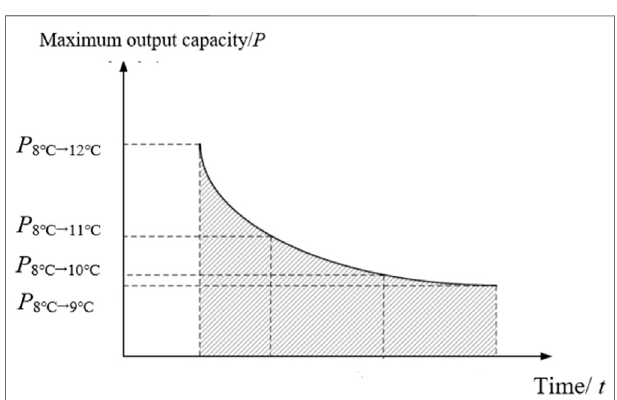
FIGURE 4 | Output characteristics of a single central air conditioning virtual